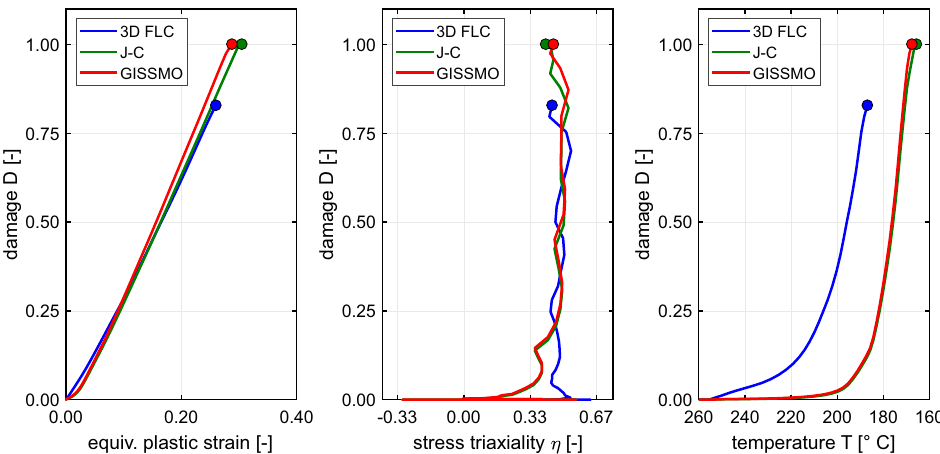
Figure 10. Loading paths of the critical elements from the 3D FLD, JC-like and GISSMO evaluation. For comparison purposes the loading path of the critical element from the 3D FLD is evaluated by damage D accumulation as given in Equation (10). The predicted onsets of necking are depicted by